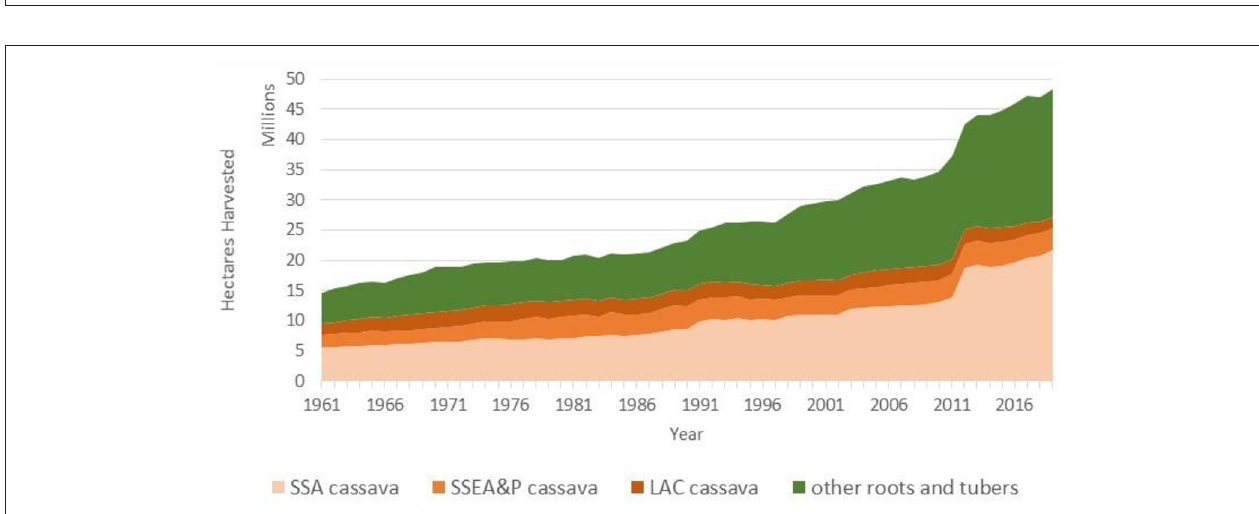
FIGURE 2 | Historical total root and tuber area harvested and cassava area harvested by region. SSA, Sub-Saharan Africa; SSEA and P, South and Southeast Asia and the Pacific; LAC, Latin America and the Caribbean. Other roots and tubers include everything else besides cassava.